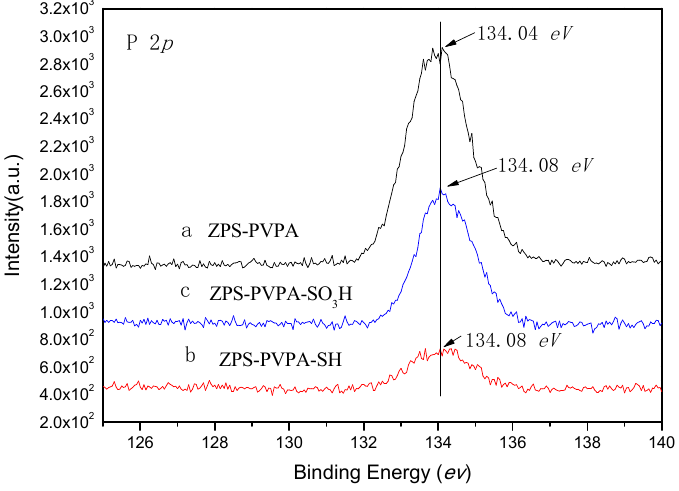
Figure 2. XPS of P 2p peaks of ( a ) ZPS–PVPA, ( b ) ZPS–PVPA–SH, and ( c ) ZPS–PVPA–SO 3 H.